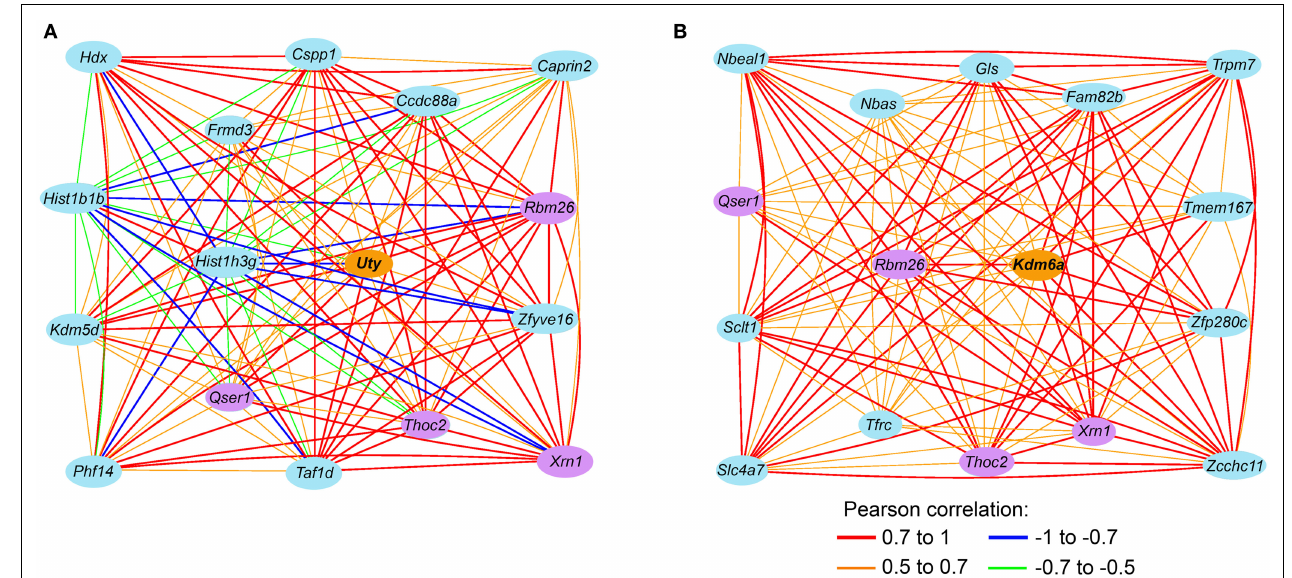
FIGURE 4 | Sex-specificity in Uty and Kdm6a ( Utx ) sub-networks. (A) This gene network is a subset of the M2 module in males and shows the top15 covariates of Uty (lines code the Pearson product correlations between transcripts). In females, Uty had poor coexpression and is relegated to F0. (B)